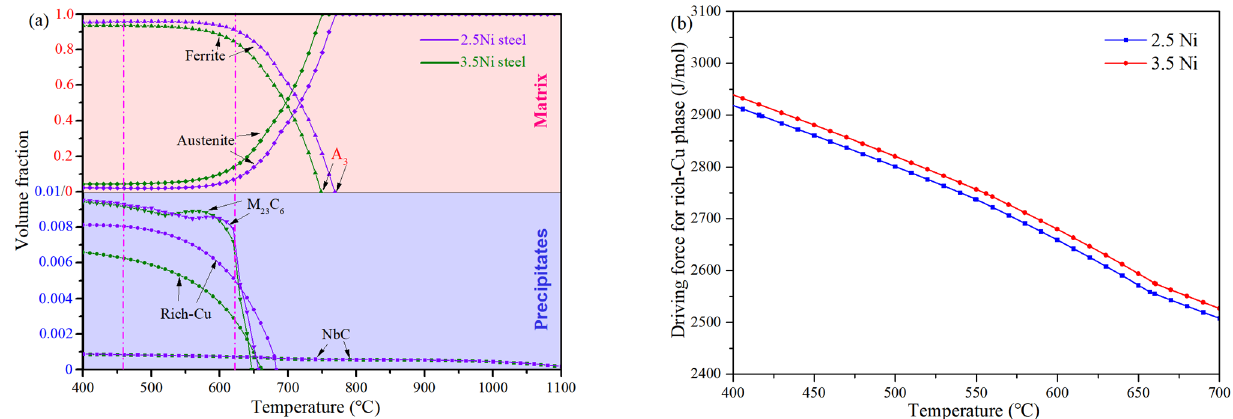
Figure 10. TC calculation results. ( a ) Volume fraction of equilibrium phases. ( b ) Driving force curves for rich-Cu precipitates.